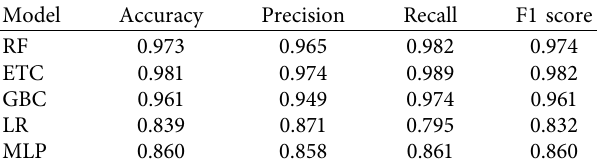
Table 11: Results of machine learning models with ADASYN data resampling.